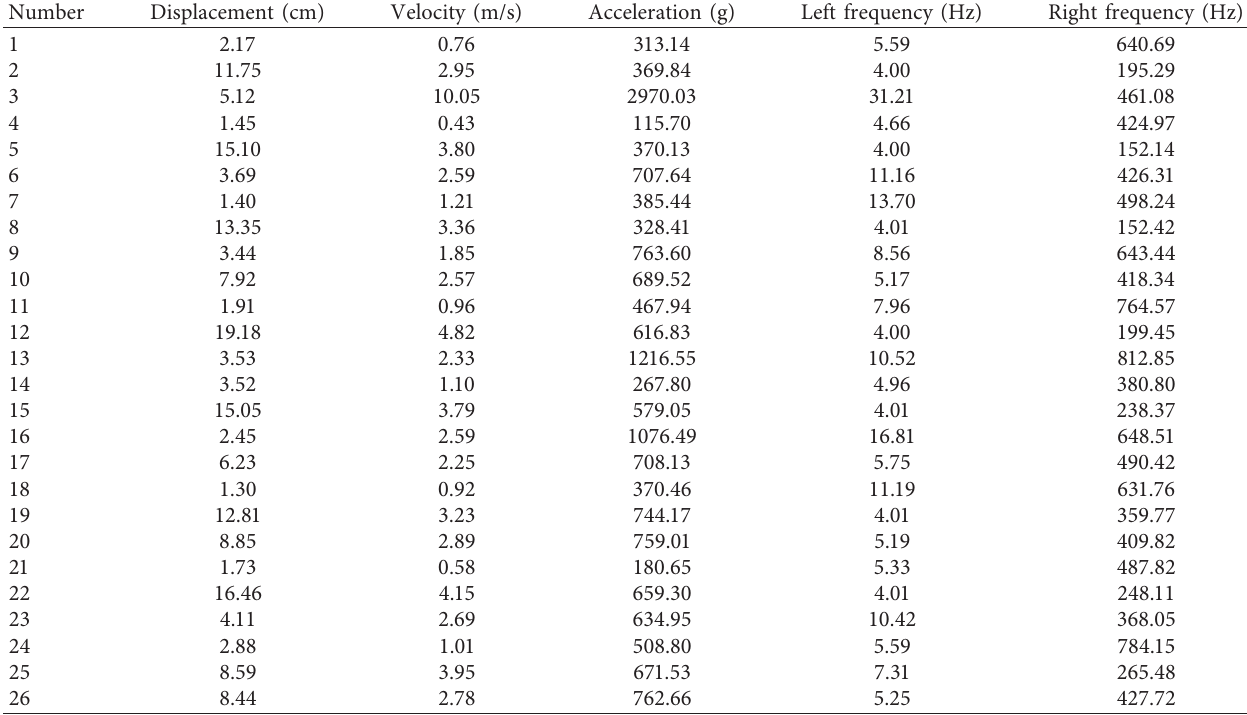
Table 4: Design spectrum value of each measuring point of inner bottom.